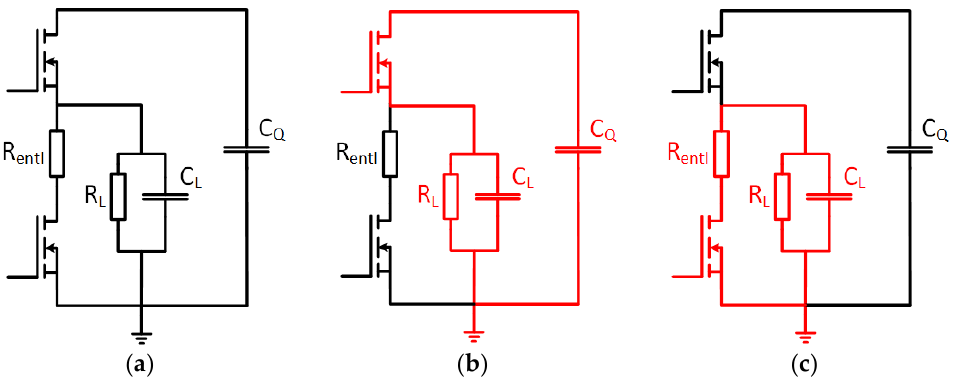
Figure 2. Circuit schematic of the operation modes of the bidirectional switch: ( a ) Bidirectional switch comprising two RF-MOSFETs, a discharge resistor (R entl ), the load resistor (R L ), load capacitance (C L ) and the capacitor for power supply (C Q ); ( b ) current flow during the nanosecond pulse; ( c ) current flow while discharging the load (R L ).